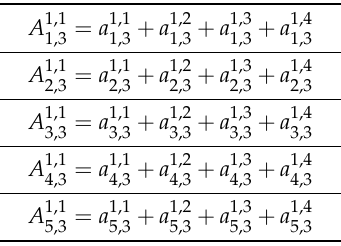
Table 2. Hydrodynamic added mass of a vertical cylindrical body in front of an orthogonal